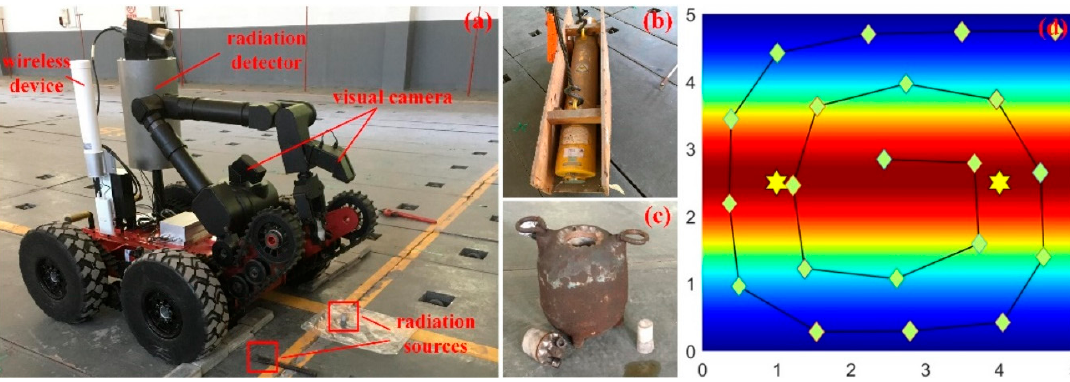
Figure 12. The localization experiment for two radiation sources. ( a ) is the global scene of the experiment. ( b , c ) shows the two radiation sources and corresponding containers respectively. ( d ) illustrates the source locations, sampling points and measurements cloud chart with GPs regression.